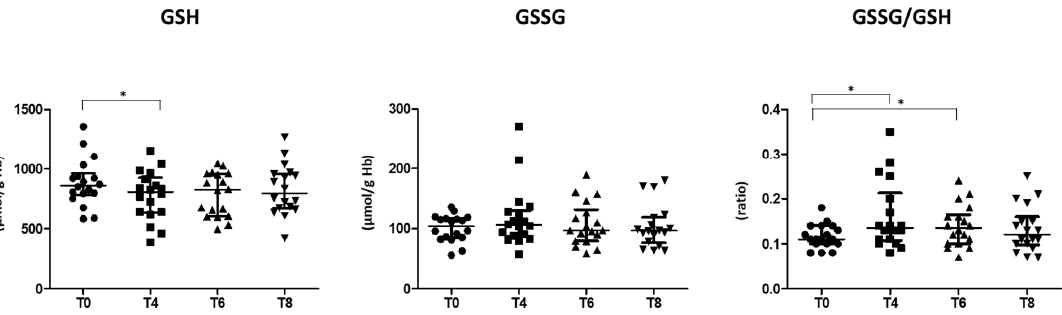
Figure 2 . Levels of reduced glutathione (GSH), disulphide glutathione (GSSG), and the ratio GSSG/GSH at baseline (T0) and at the indicated times following an oral glucose load in RBCs isolated from prediabetic patients. ● T0; ■ T4; ▲ T6; ▼ T8. Data are expressed as median and interquartile range. n = 18; * p < 0.05.